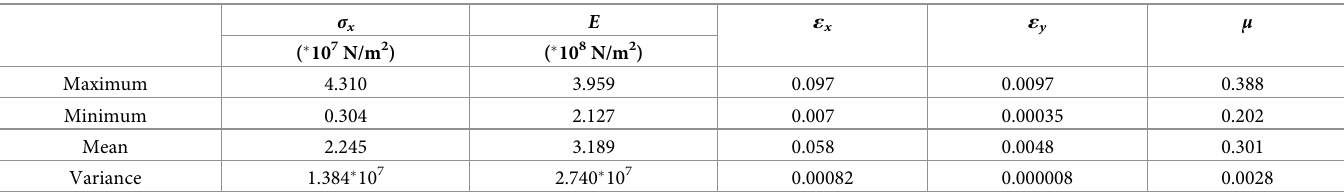
Table 4. Statistics of the parameters and variables in dataset 3.